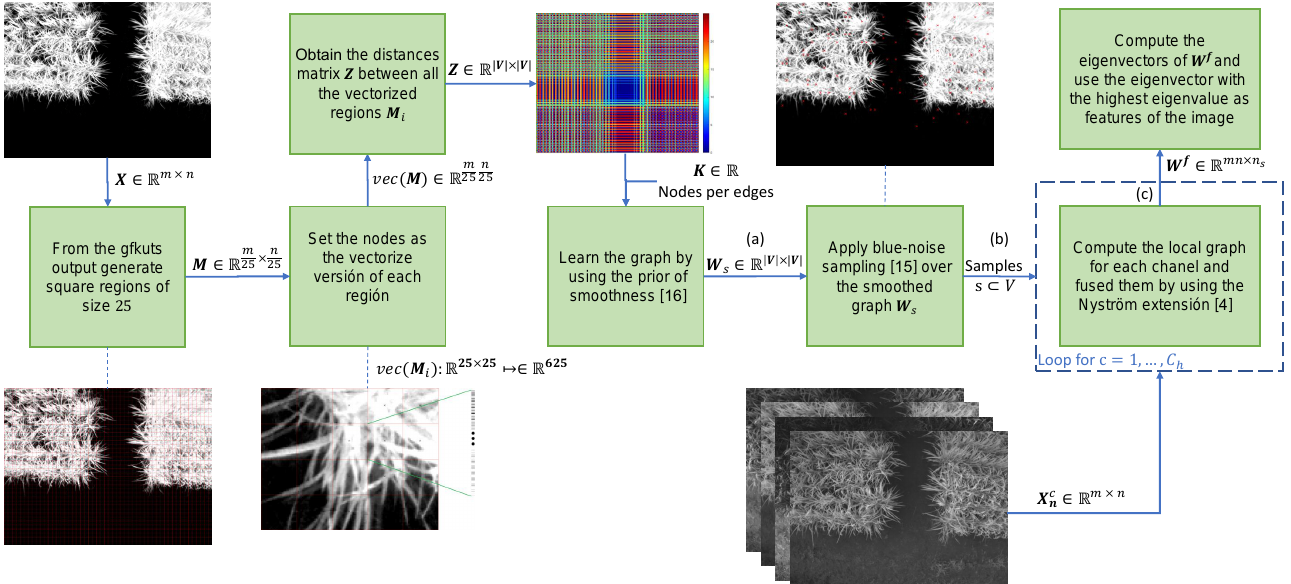
Figure 3. Proposed method based on the three stages: ( a ) Graph learning with prior smoothness, ( b ) blue-noise sampling to inject the samples to Nyström extension and ( c ) the fusion of the the multispectral images to extract features of the